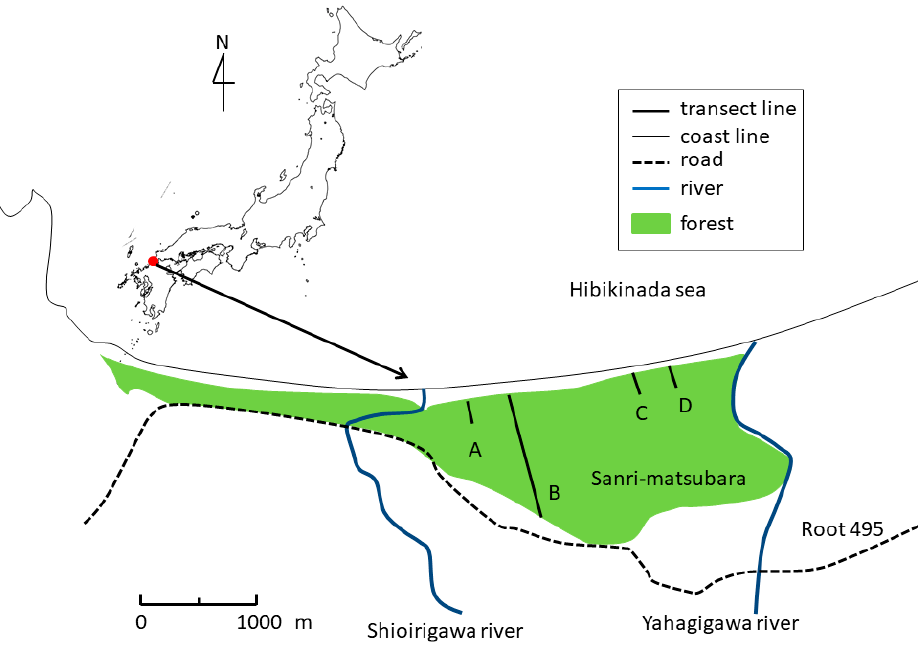
Figure 1. Map showing the location of Sanri-Matsubara forest, south-western Japan, and the position of survey transects ( A : 300 m; B : 1040 m; C : 340 m; and D : 300 m) established in the coastal forest